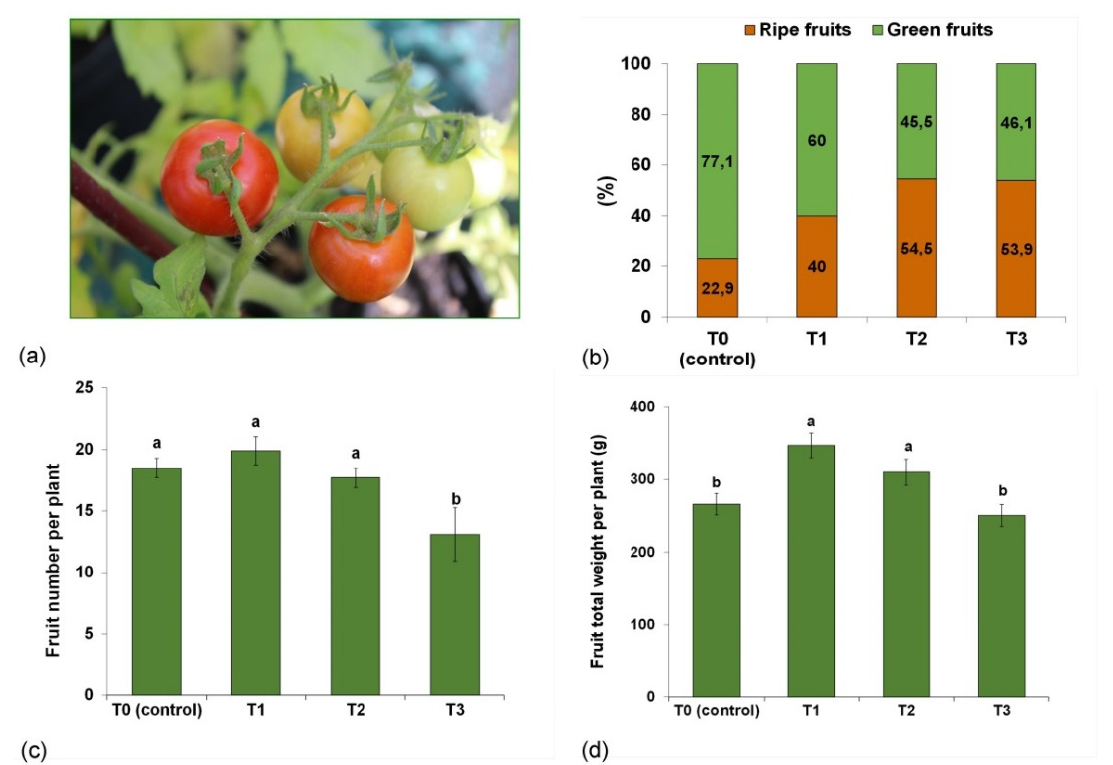
Figure 4. Effects of compost-enriched media: T0 (control—100% peat substrate); T1 (25% compost, 30% sphagnum peat, 15% fen peat, 20% pine bark, 10% wood fiber); T2 (30% compost, 20% sphagnum peat, 30% fen peat, 10% pine bark, 10% wood fiber); and T3 (30% compost, 0% sphagnum peat, 30% fen peat, 30% pine bark, 10% woody fiber) on the fruit yield: ( a ) ripening fruit in clusters; ( b ) percentage (%) of ripe fruits per plant; ( c ) number of fruits per plant; ( d ) fresh weight of total fruits per plant. Vertical errors bars indicate the standard error of the mean. Different letters indicate a significant difference at p ≤ 0.05.